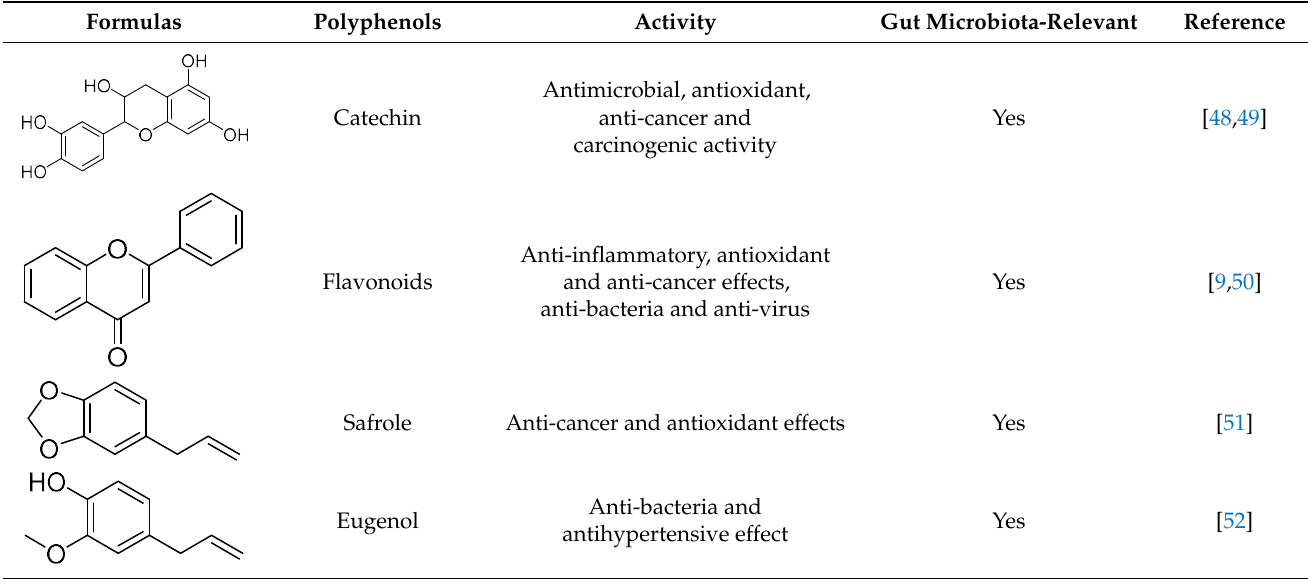
Table 1. Prominent polyphenols in AN and their activities.